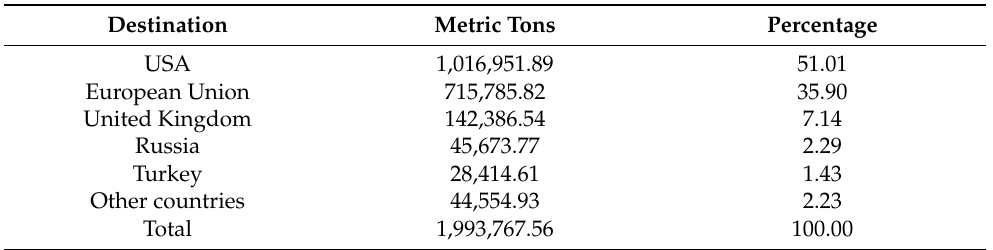
Table 1. Details of the Costa Rican pineapple exportations during 2020 (first year of COVID-19 pan- demic outbreak). Source: own design based on the Costa Rican Foreign Trade Promoter (PROCOMER) data